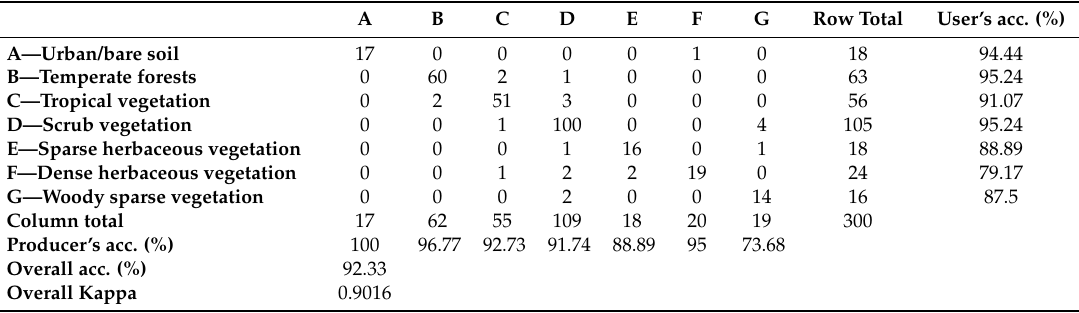
Table 5. Error matrix for land use-cover, 1986. Natural Protected Area Altas Cumbres. Victoria, Tamaulipas,